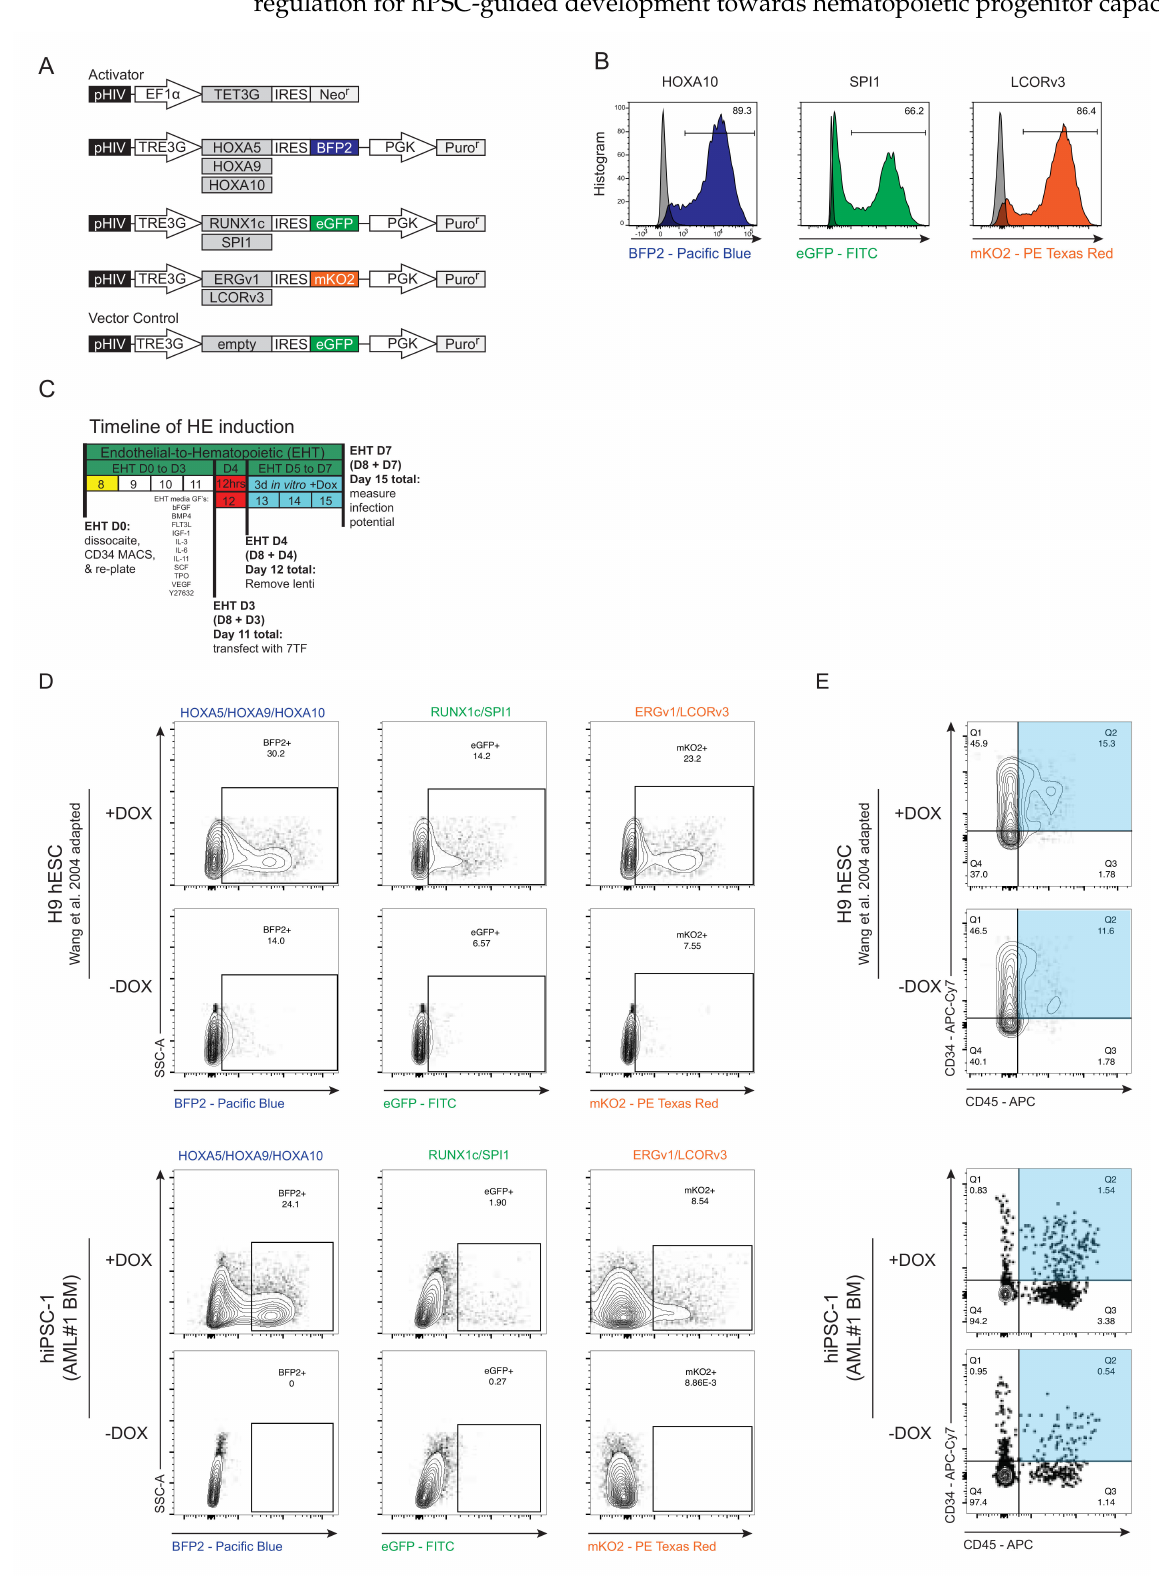
Figure 3. Generation and forced expression of 7TF under HE conditions in AML-iPSCs. ( A )